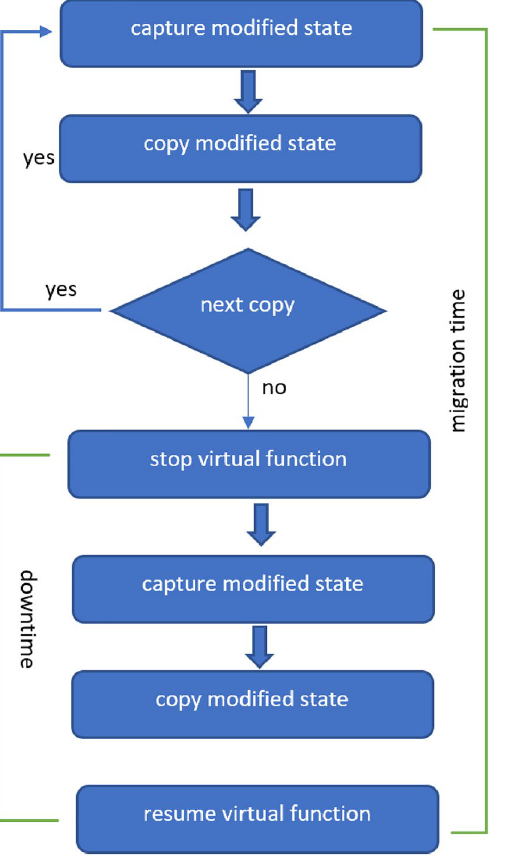
Figure 5. Live migration